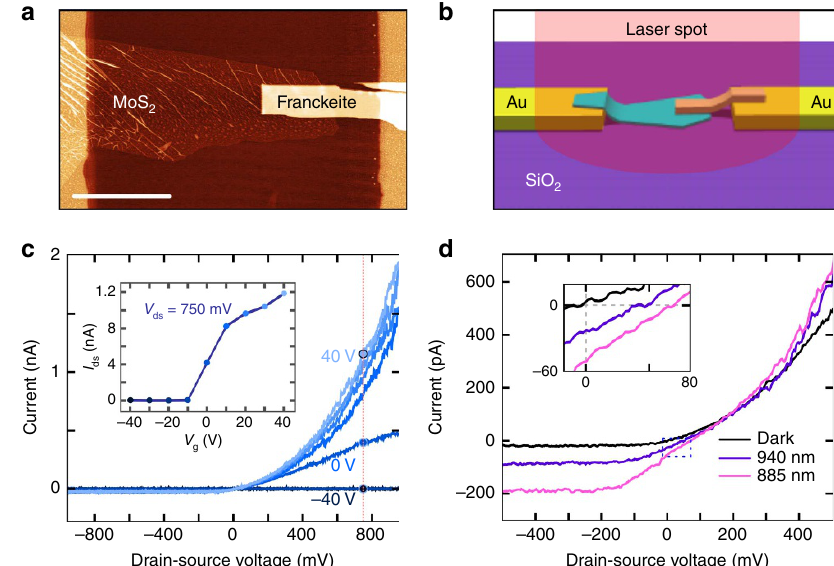
Figure 5 | p-n junction made by stacking mechanically exfoliated flakes of MoS 2 and franckeite. ( a ) AFM topographic image of the p-n junction. The scale bar is 10 m m. ( b ) Artistic representation of the p-n junction shown in a . ( c ) Diode-like current-voltage ( I ds (cid:3) V ds ) curve of the p-n junction in dark conditions for different applied back-gate voltages. Inset: gate trace extracted from the I ds (cid:3) V ds at V ds ¼ 750mV. The p-n junction switches on at an applied back-gate voltage of 0V. ( d ) Diode-like current-voltage ( I ds (cid:3) V ds ) curve of the p-n junction at an applied back-gate voltage of V g ¼ 40V in dark conditions and upon illumination with lasers of 940 and 885nm wavelengths, both with a power of 140 m W. The inset highlights the region around V ds ¼ 0V and I ds ¼ 0V to show the short-circuit current ( I sc ) and open circuit voltage ( V oc ) values, obtaining I sc ¼ (cid:3) 27pA and V oc ¼ 55mVat 940nm, and I sc ¼ (cid:3) 51pA and V oc ¼ 77mV at